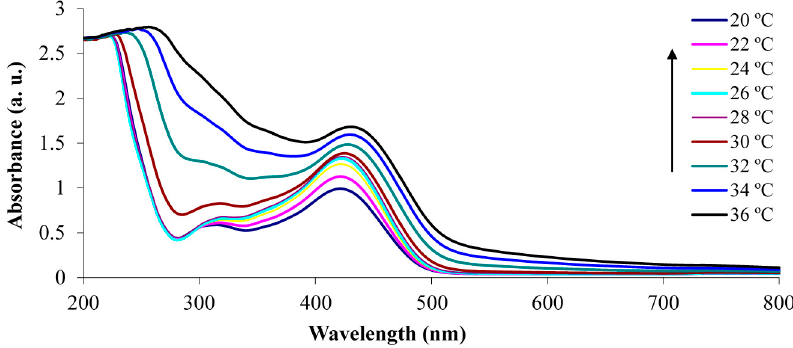
Figure 2. UV-Vis absorbance spectra of the non-irradiated 0.1% w/w p(NiPAAm-BSP-AA) linear copolymer solution in DI water.